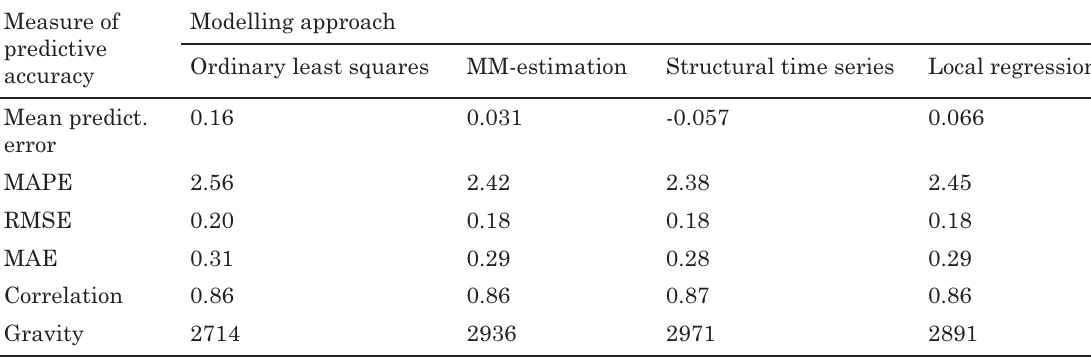
Table 6. Post-sample prediction statistics for different approaches Measure of